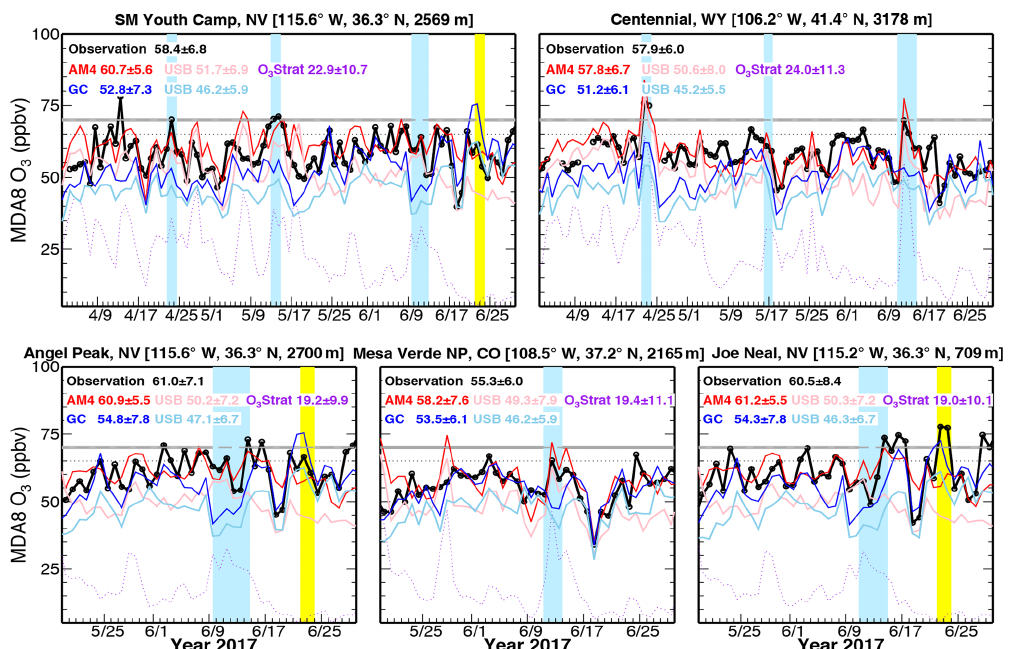
Figure 4. Time series of daily MDA8 O 3 at Spring Mountain Youth Camp (SMYC) in Nevada and Centennial in Wyoming from April to June and at Angel Peak, Mesa Verde, and Joe Neal during the FAST -LVOS study period, highlighting stratospheric intrusion events (blue shading) and wildfire events (yellow shading). The SMYC O 3 monitor is located only about 125m below and 800m west of the Angel Peak summit where the mobile lab was parked. Shown are total MDA8 O 3 from observations (black) and simulations by GFDL-AM4 (red) and GEOS-Chem (blue), together with USB O 3 from GFDL-AM4 (pink) and GEOS-Chem (light blue). The dashed purple line shows AM4 stratospheric O 3 tracers The horizontal lines denote the current NAAQS level of 70ppbv and a possible future standard of 65ppbv.